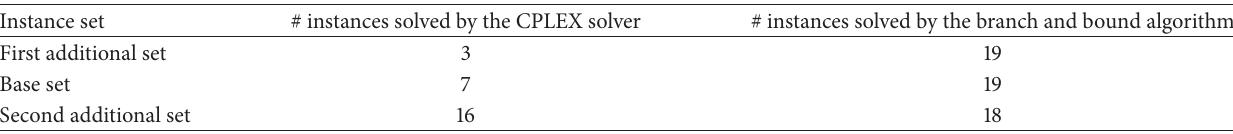
Table 4: Number of instances of each set of group IV out of 20 solved to optimality in 10 seconds by the branch and bound algorithm and the CPLEX solver.